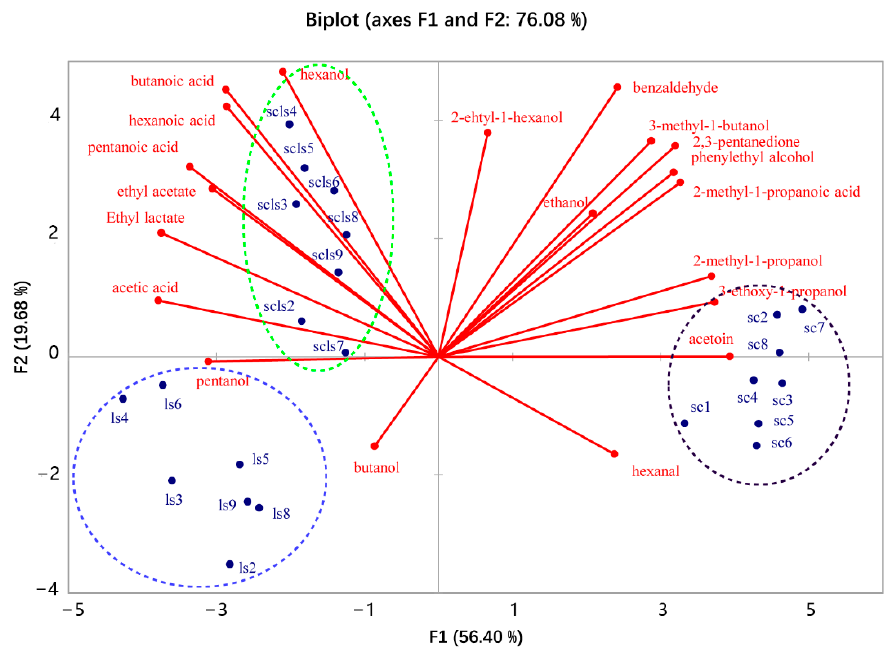
Figure 3. Biplot of the PCA analysis on the volatiles of sourdoughs fermented by F. sanfranciscensis LS1 and S. cerevisiae 9Y3 individually and in combination for 12 h. sc: dough fermented with S. cerevisiae 9Y3; ls: dough fermented with F. sanfranciscensis LS1. scls: dough fermented with S. cerevisiae 9Y3 and F. sanfranciscensis LS1.